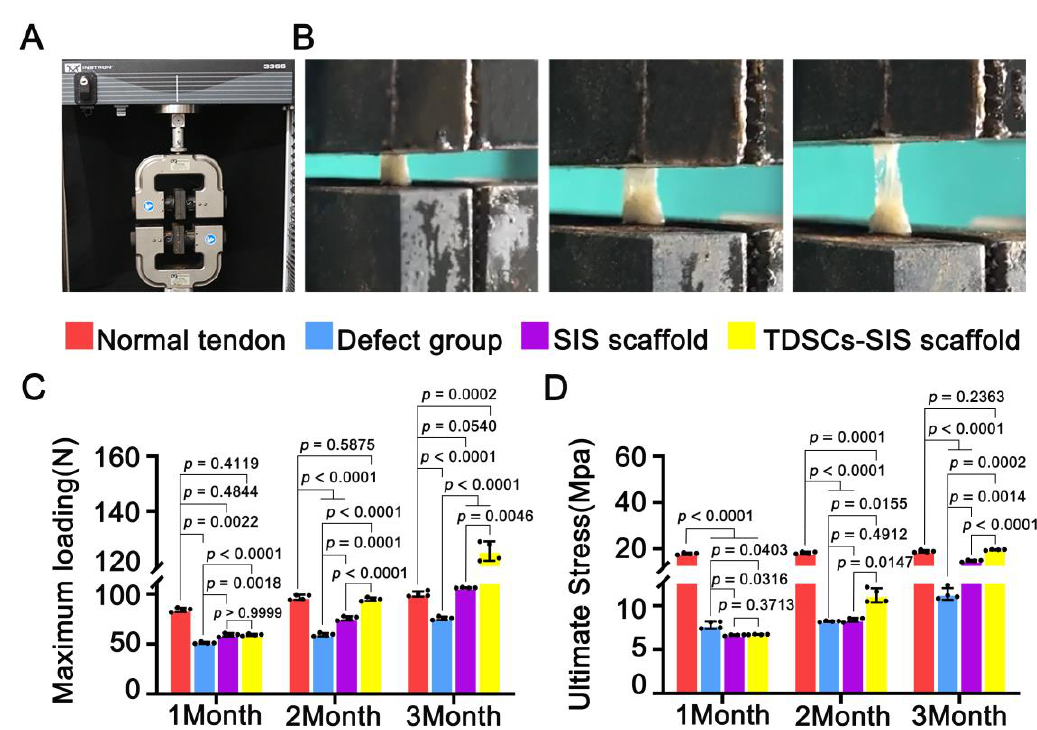
Figure Figure 5. TDSCs – SIS scaffold facilitated biomechanical recovery of the Achilles tendon. ( A , B ) Bio- mechanical test was performed; the Achilles tendon was stretched at a uniform rate until it was completely stretched. ( C , D ). Biomechanical properties, including maximum loading and ultimate